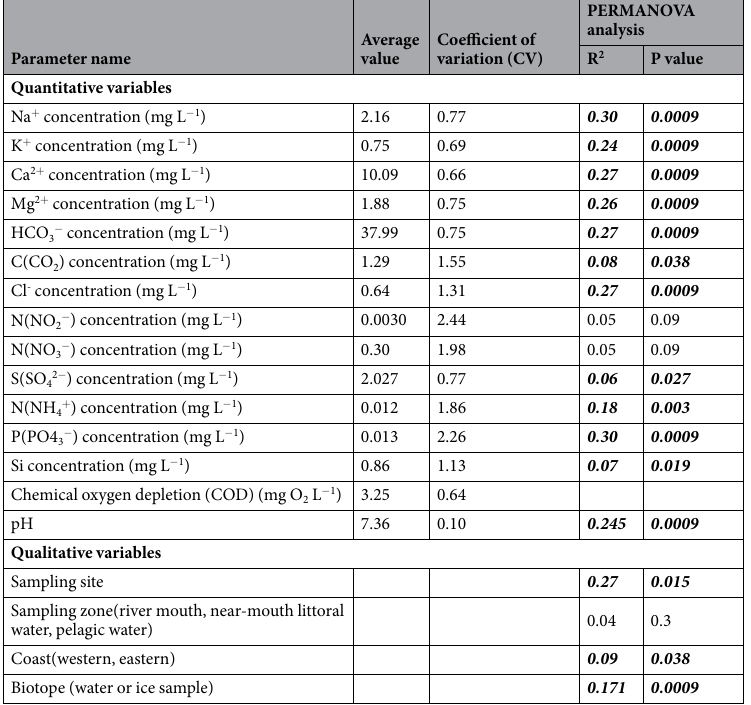
water column) is a significant factor that influences the values of biological parameters (Table 1). Water column featured higher concentrations of Na + , Ca 2 + , Mg 2 + , S(SO 42 − ), and HCO 3 − , higher pH and lower C(CO 2 ) concen- tration. The second is less pronounced and separates the samples from the eastern and western coasts of Lake Baikal. This separation also confirms by PERMANOVA analysis (Table 1). Western samples as a rule had higher Cl − and P(PO4 3 − ) concentration as well as lower concentrations of S(SO 42 ) − and silicon (Si). A particularly high concentration of Cl − and P(PO4 3 − ) was in the sample of water and ice from the mouth of the Cheremshanka river (Fig. 2a). When hydrochemical parameters were treated as dependent variables (Fig. 2b, PERMANOVA analysis Table 2), the following qualitative and quantitative factors were found to significantly affect them: C org , ∑ PB, Сhl_a, ∑ PP, BOD, NB, ∑ BP, OB, TMC22C, biotope (water or ice) and Coast (western, eastern). BOD, NB, ∑ BP, and biotope had the strongest effects (R 2 > 0.2). The ice and water samples (Fig. 2b, PERMANOVA analysis Table 2) differ in chemical composition. This usually comes from increased biological activity in the water sam- ples (i.e., higher values of C org , ∑ PB, Сhl_a, ∑ PP, BOD, NB, OB and TMC22C). Some western water samples (Fig. 2b) exhibited very high values of biological parameters C org , ∑ PB, Сhl_a, ∑ PP, BOD, NB, ∑ BP, OB and TMC22C. Particularly high values of these parameters were observed for the water samples from the mouth of Bolshaya Cheremshanka river. The investigated area of the western coast of Lake Baikal in the area of Listvyanka settlement, especially in the mouths of the rivers, also showed high values of biological parameters (implying high rates of biological pro- cesses) (Fig. 2). In addition to biological parameters that significantly affect hydrochemical variables, this sample had the highest counts of organotrophic bacteria (OB), thermotolerant bacteria cultivated at 22 °C (TMC22C), and thermotolerant bacteria cultivated at 37 °C (TMC37C). These samples showed high concentrations of Cl − , which is an indicator of anthropogenic pollution. One of the ice samples taken at the same site had an even higher Cl − concentration and lower bacterial and phytoplankton activity (roughly similar to other ice samples from the lake) (Fig. 2). All rivers (Kamenushka, Krestovka, and Bolshaya Cheremshanaya) flowing into the lake in the area pass through the Listvyanka settlement in sections ranging from 1.6 to 2.8 km (Fig. 1). For both hydrochemical and biological parameters, parameter variance did not appear to correlate with the significance of the parameter’s effect on the diversity of sampling sites (Tables 1 and 2). Parameters with high coef- ficient of variation between the samples (CV > 1) may have little impact on the patterns of other parameters. In contrast, parameters with low coefficient of variation (CV < 1) may affect other parameters with high significance and R 2 (R 2 > 0.3). Analysis of the correlation between hydrochemical and biological parameters of samples from under-ice water. Because the water samples were significantly different from the ice samples on both hydro- chemical and biological parameters, only the water samples were used in the correlation analysis and heat map;